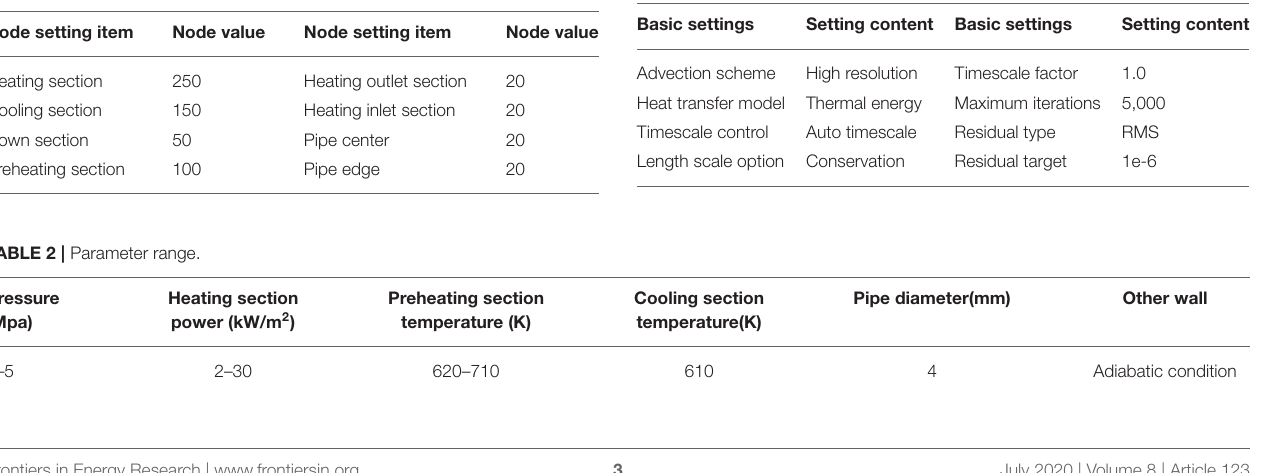
TABLE 1 | Grid node division information.